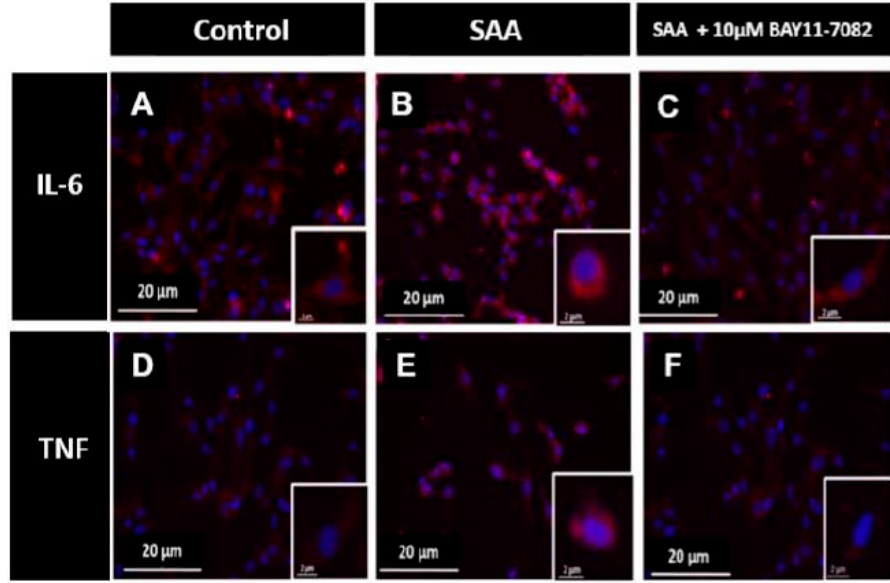
Figure 4. Changes in intracellular IL-6 and TNF in response to SAA and BAY-11-7082. HCtAEC were treated with SAA and with and without BAY11-7082 pre-incubation. Next, cellular TNF and IL-6 content and distribution was visualised by immunocytochemistry. For all images shown, nuclei were stained with DAPI (blue) or IL-6 + (A-C) or TNF + (D-F) immune-fluorescence using an appropriate secondary antibody (red) under 20× of fluorescence microscope. Representative images are shown for cells treated with DMSO (vehicle control) (A and D) , 10 µg/mL SAA (B and E) or pre-incubated with 10 µM BAY11-7082 (C and F) prior to addition of 10 µg/mL SAA. Data shown are representative of 5 fields and (n = 2 control, n = 2 SAA or n = 3 BAY11-7082 + SAA independent repeat studies). Insets to panels A-F show higher magnification images of representative single cells from the different treatment groups.